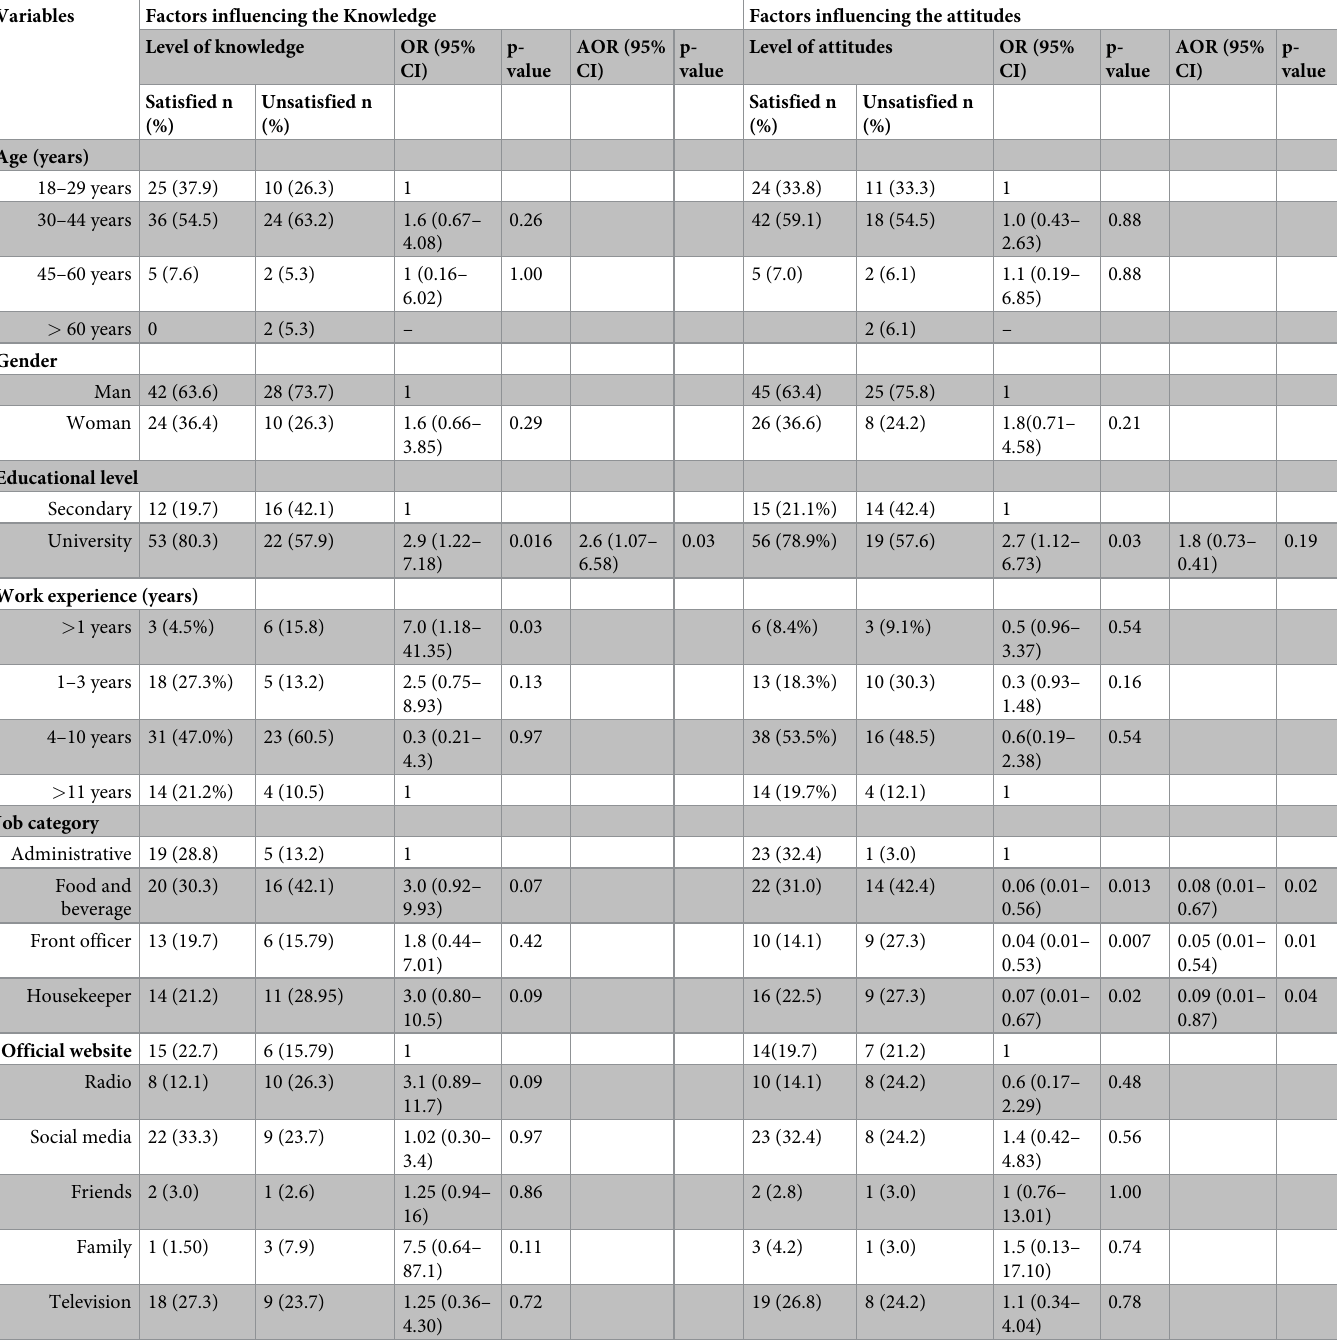
Table 4. Analysis of sociodemographic characteristics as factors influencing knowledge and attitudes on COVID-19 among hotels’ staff in